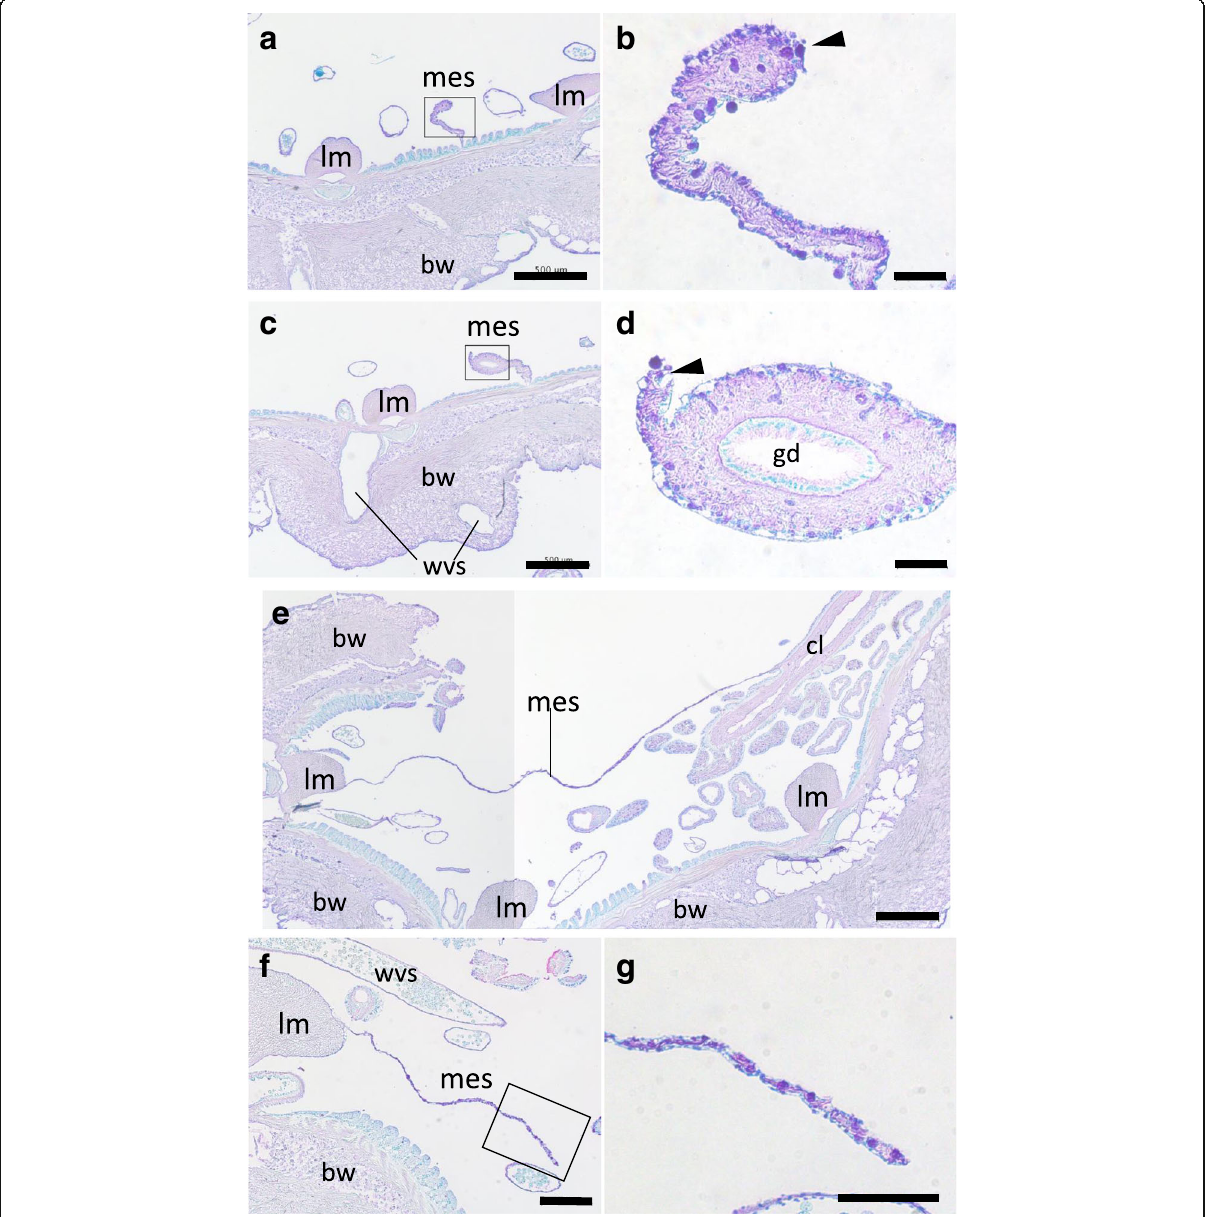
Fig. 5 Histology of the tissues at stage I. Cross sections of the body at stage I (0 dpe) were stained with TB, mainly focusing on the anterior ( a - d ) and posterior ( e , f ) mesenteries. b , d and g are high-magnification views of the boxed areas in a , c and f , respectively. a , b Anterior tissue, posterior to the anterior rudiment. c , d Anterior tissue posterior than a and b . The gonadal duct remains in the mesentery, but no structures are present at the free end. e Posterior tissue. The cloaca and the body wall are connected by the mesentery. f , g Posterior tissue, anterior than e . In b , d and g , no tubular structures nor developed cell mass are observed at the free edge of the mesentery (arrowhead). bw, body wall; cl, cloaca; gd, gonadal duct; lm, longitudinal muscle; mes, mesentery; wvs: a part of the water vascular system (radial water canals, etc.). Arrowheads indicate the free edges of the mesentery. Scale bars 500 μ m in a , c , e ; 200 μ m in f ; 50 μ m in b , d ,